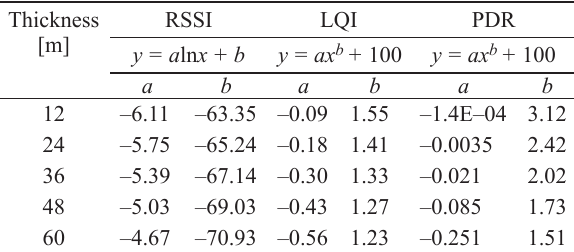
Table 2. Empirical equations for concrete block ( x denotes T-R separation distance) Thickness [m]